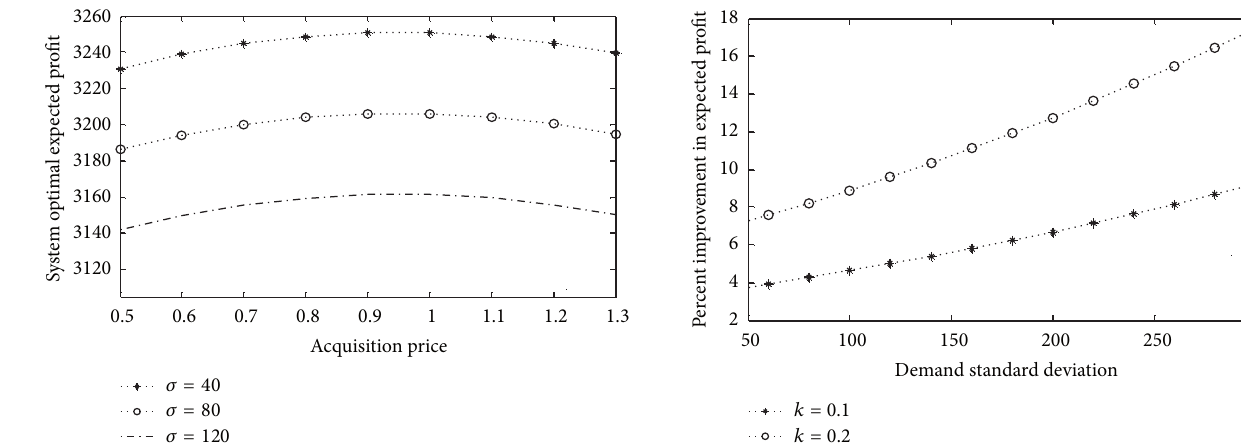
Figure2:Optimalexpectedprofitsfordifferentstandarddeviations.